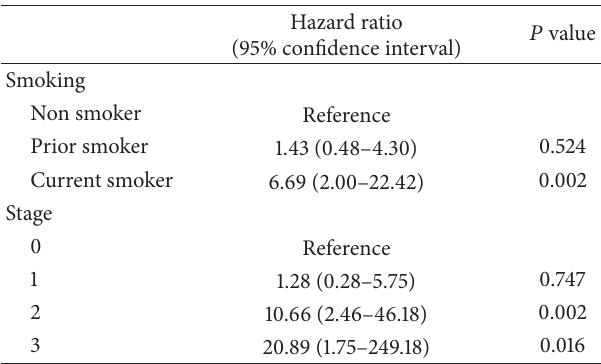
Table 3: Multivariable Cox regression for recurrence-free